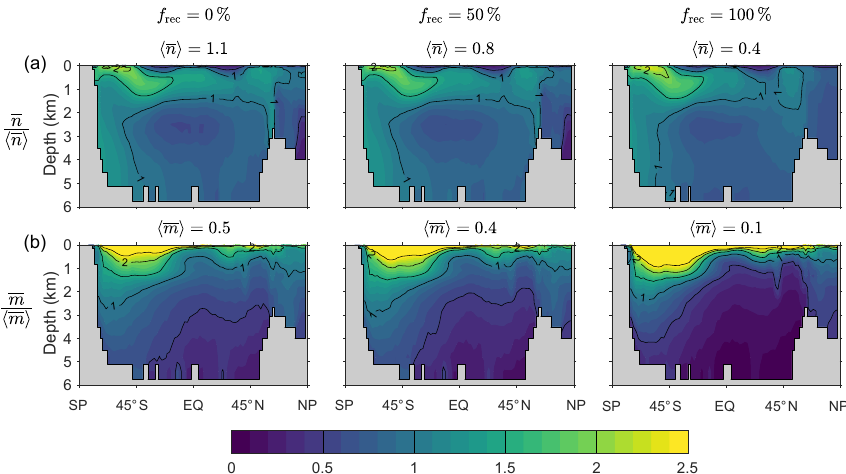
Figure D1. (a) The zonal means of n( r ) normalized by the corresponding global averages (cid:104) n (cid:105) for our typical state estimate re-optimized with three very different recyclable fractions: f rec = 0 , 50 , and 100%. (b) The corresponding normalized zonal means of m( r ) . The values of the global averages, (cid:104) n (cid:105) and (cid:104) m (cid:105) , are given in the plot